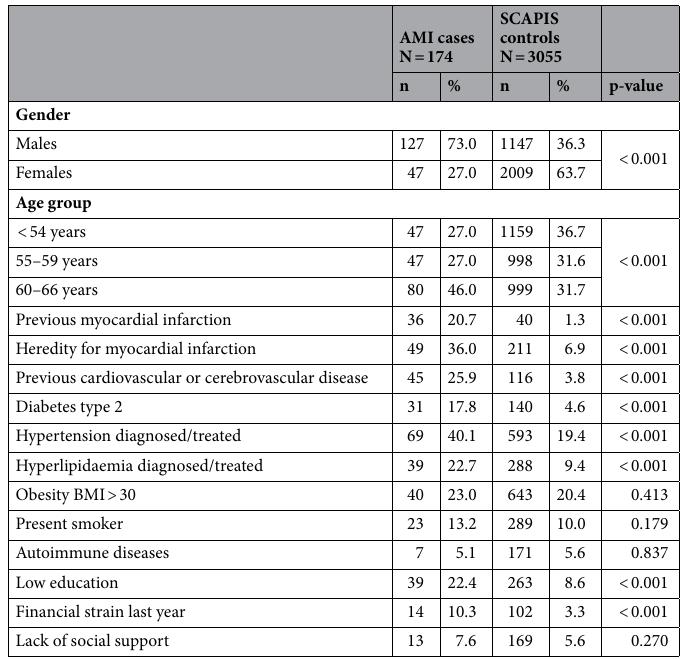
Table 1. Description of the AMI-cases (N = 174) and the SCAPIS-controls (N = 3